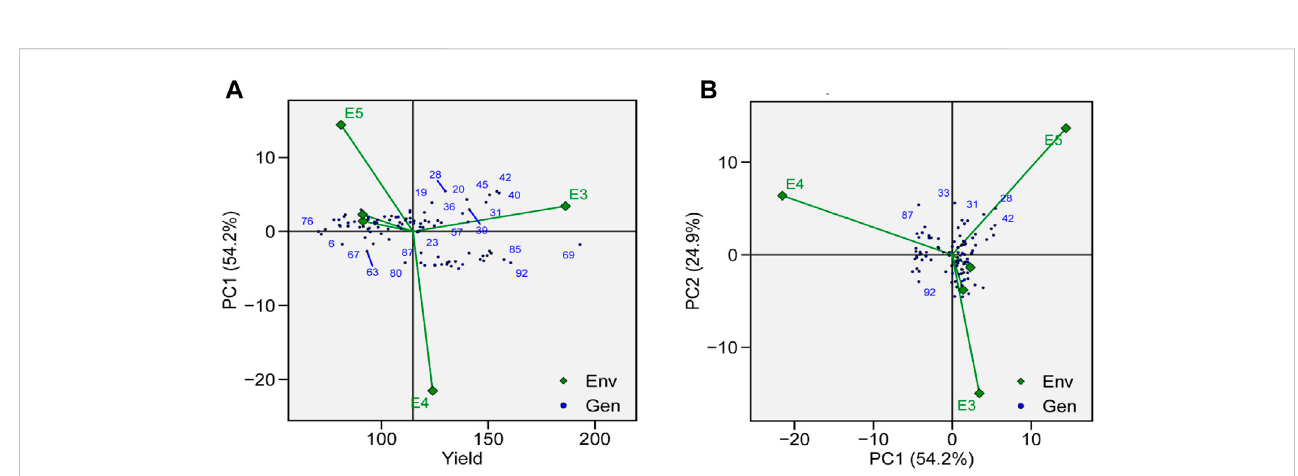
FIGURE 6 (A) AMMI main effects biplot for TY of genotypes across fi ve environments. (B) The scatter plot of 96 soybean genotypes ’ seed yield data across fi ve environments explained 81.1% of the total variation. At the x-axis, PC1 explains (54.2%), and at the y-axis axis, PC2 explains